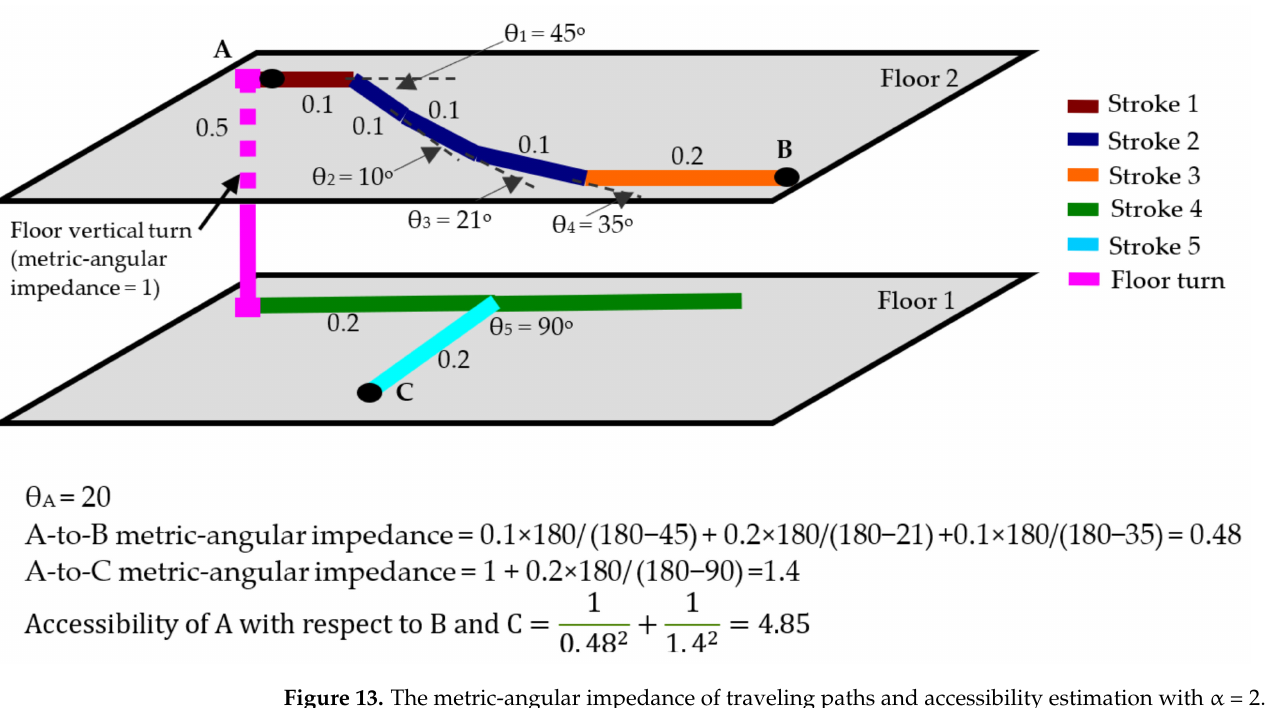
Figure 13. The metric-angular impedance of traveling paths and accessibility estimation with α =